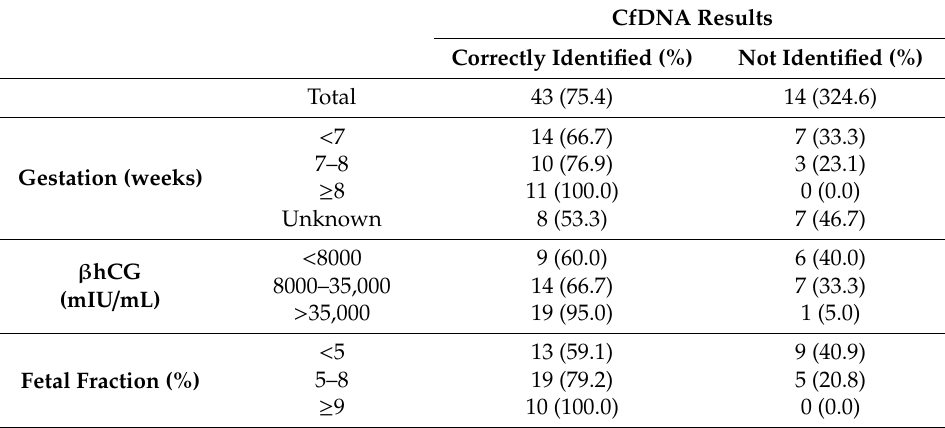
Table 3. CfDNA vs karyotype of